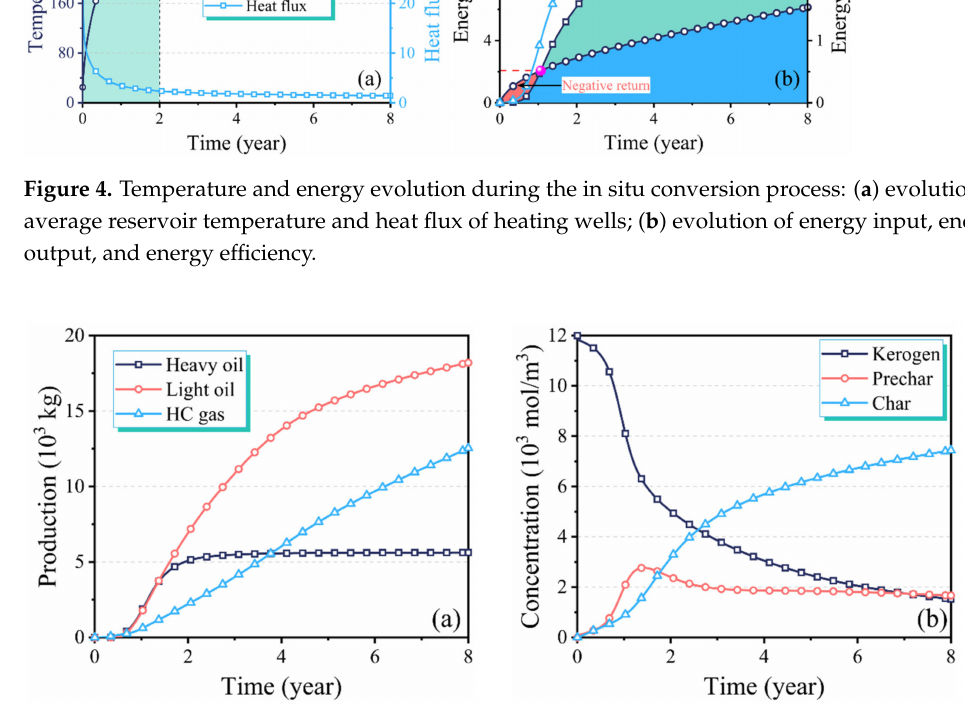
Figure 5. Evolution of production of fluid components and concentration of solid components during the in situ conversion process: ( a ) cumulative production of heavy oil, light oil, and hydrocarbon gas; ( b ) the average concentration of kerogen, prechar, and